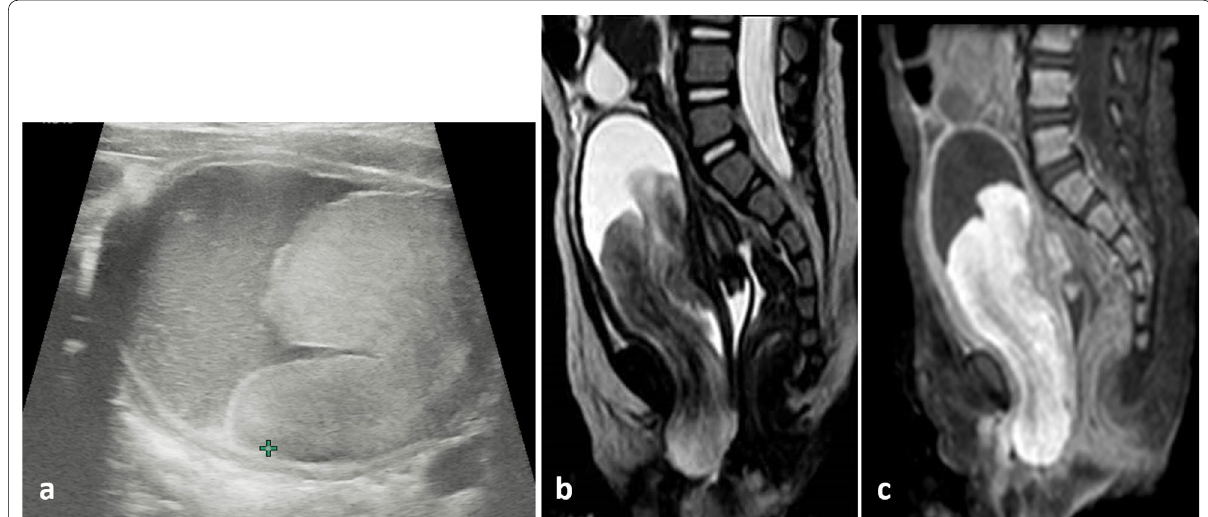
Fig. 15 15-month-old girl with hematuria and diagnosed with urinary bladder rhabdomyosarcoma. a Ultrasound shows a large mass protruding into the urinary ladder. b Sagittal T2-WI and c sagittal fat sat post-contrast T1-WI confirms the presence of the mass with better demonstration of its extension and mass effect (note the fluid filled vagina (asterisk)